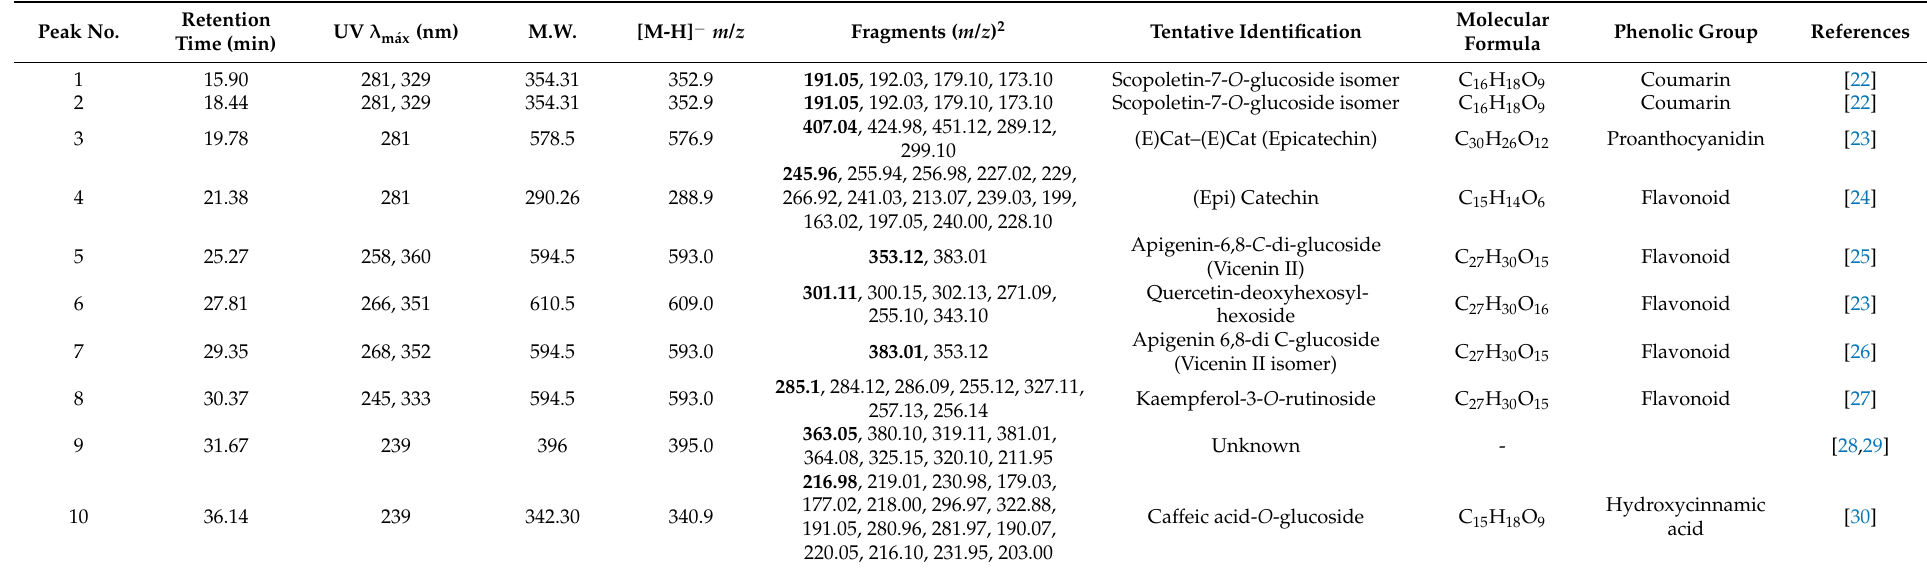
Table 6. HPLC-ESI-MS identification of phytochemicals extracted from H. patens . Peak